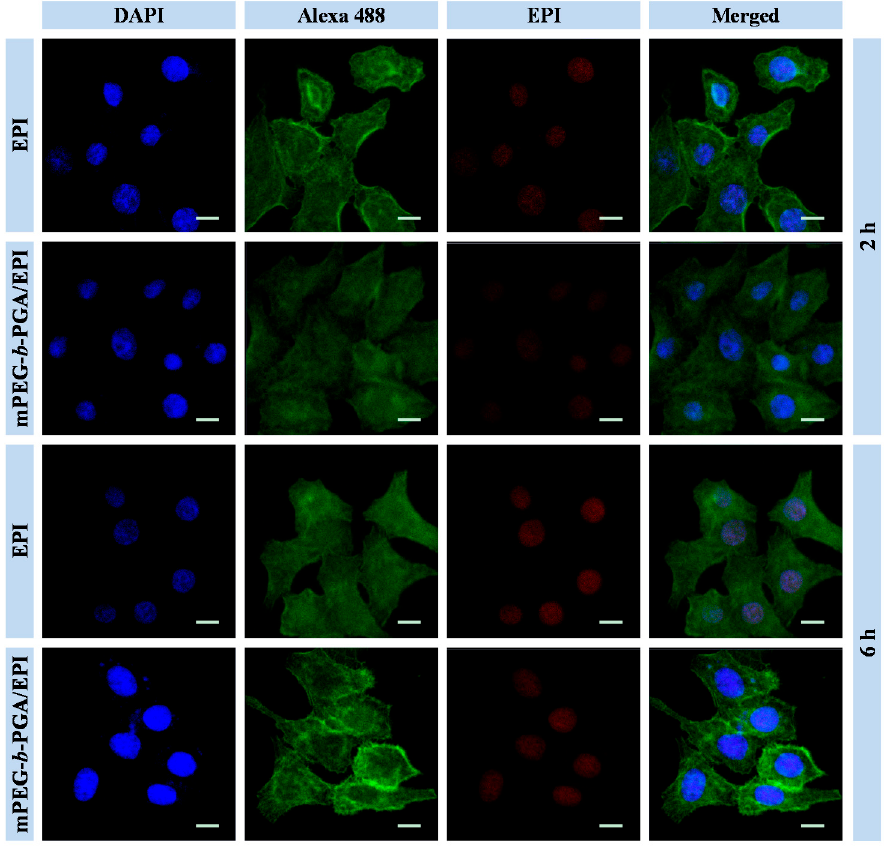
Figure 4. Cellular uptake microimages of HepG2 cells after incubation with free EPI or mPEG- b -PGA/EPI for 2 or 6 h. Scale bar: 25.0 μ m.